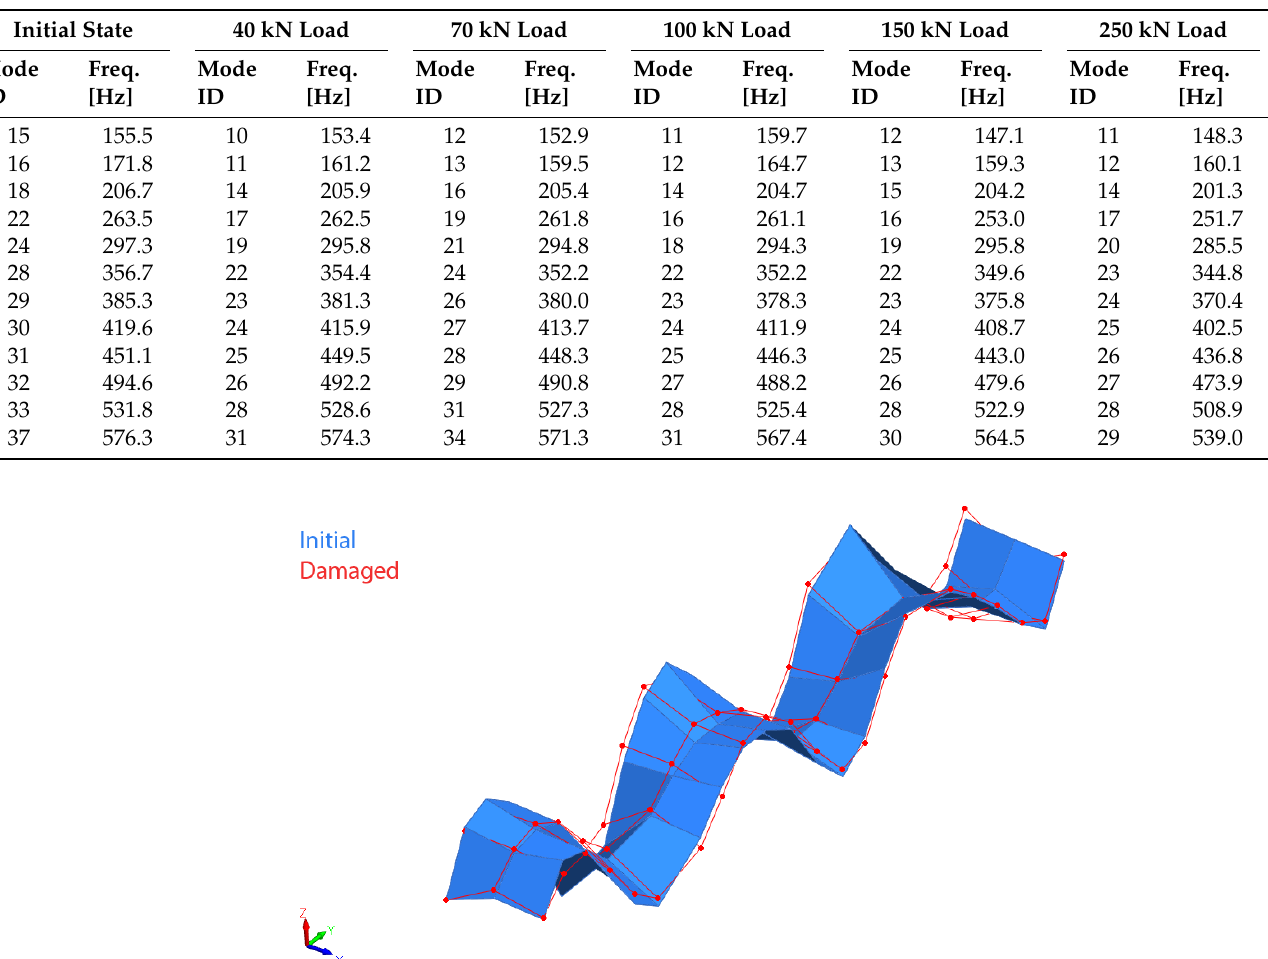
Table 4. Pair selection-criteria summary.